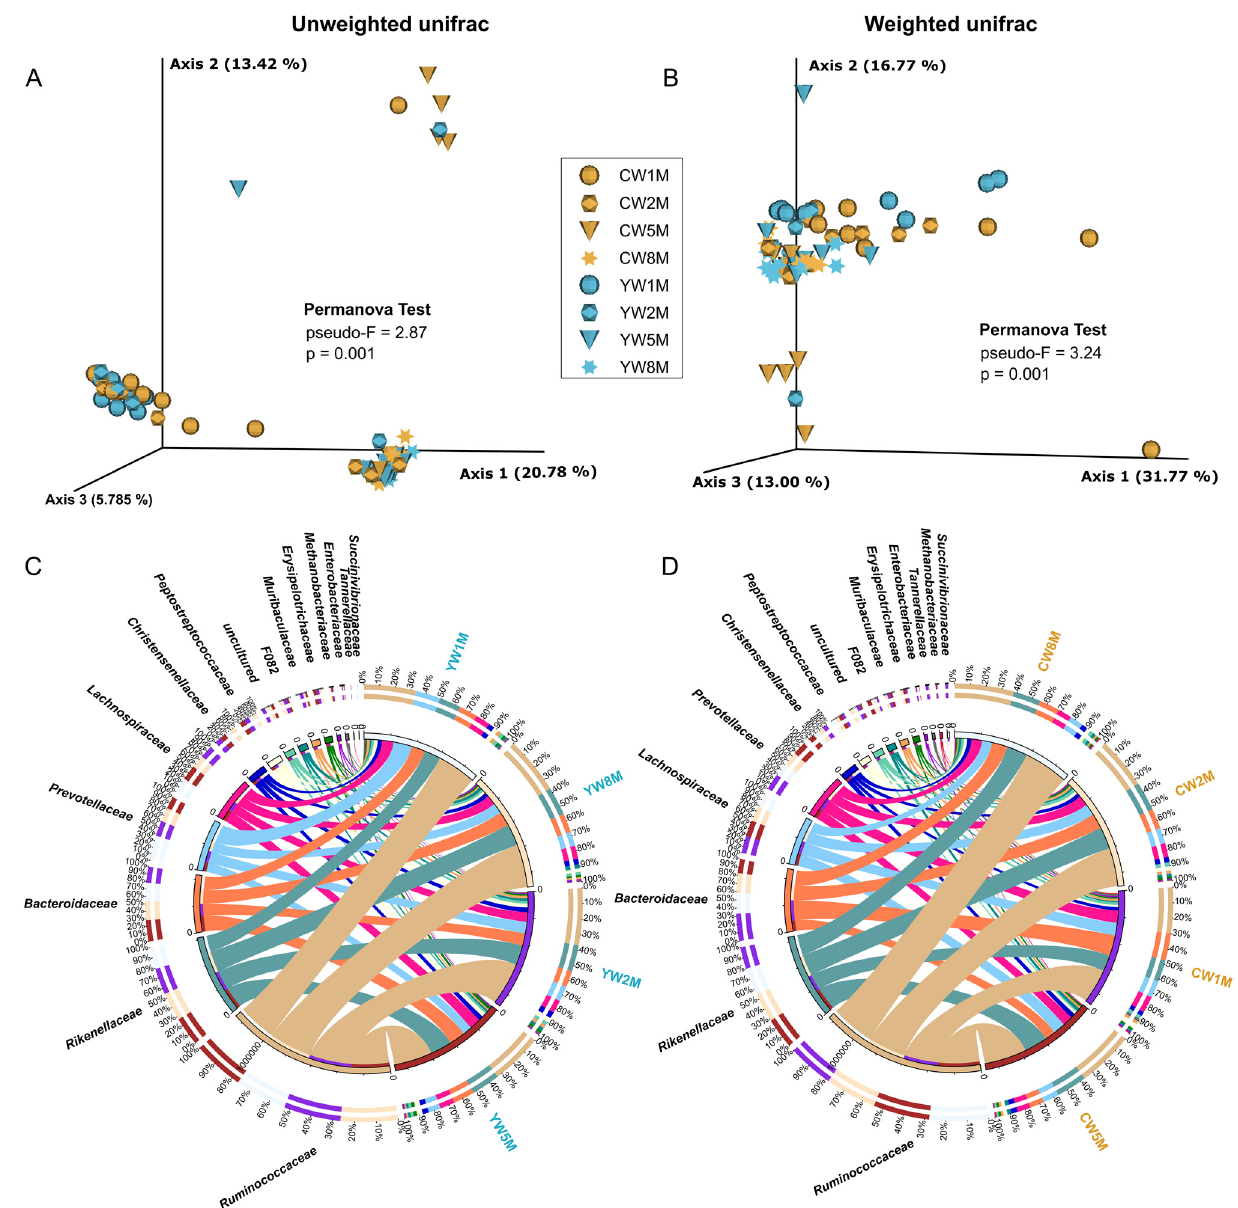
Figure 3. Beta diversity analysis of the fecal microbial community in yak and cattle calves at different months after weaning. ( A ) PCoA plot based on unweighted unifrac distance shows the differences between yak and cattle calves in different months after weaning. ( B ) PcoA plot based on weighted unifrac distance shows the differences between yak and cattle calves in different months after weaning. Circos diagram shows the composition of fecal microbiota at the family level (Top15) of yak ( C ) and cattle calves ( D ) in different months after weaning, respectively. The length of the bars on the outer ring and the numbers on the inner ring represent the percentage of relative abundance of genera detected in each sample and the number of sequences in each sample, respectively. The bands with different colors show the source of each sequence affiliated with different clusters.